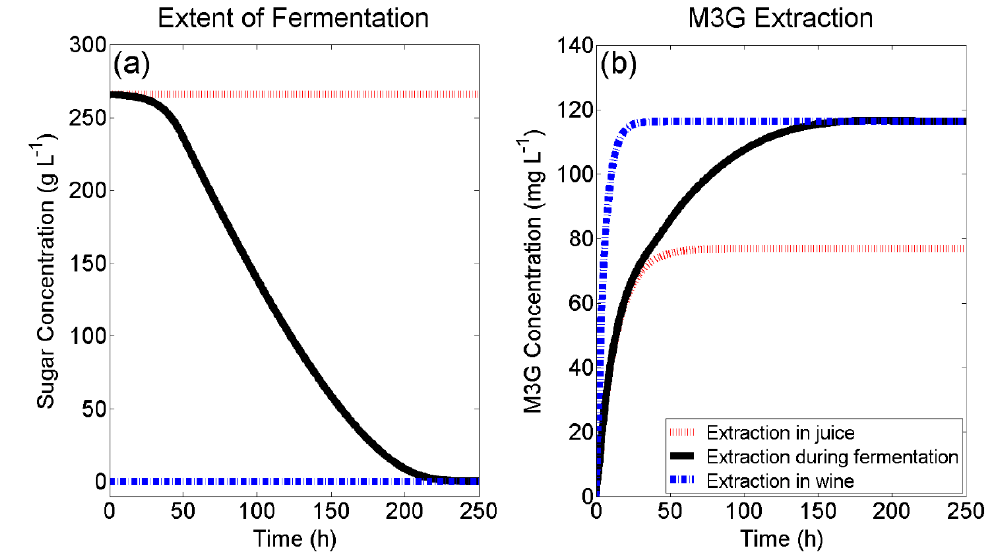
Figure 3. ( a ) Simulated red wine fermentation kinetics and ( b ) the resulting simulated extraction kinetics of M3G. Red and blue lines indicate the rate and extent of M3G extraction that would occur under constant liquid phase conditions for juice and wine, respectively.